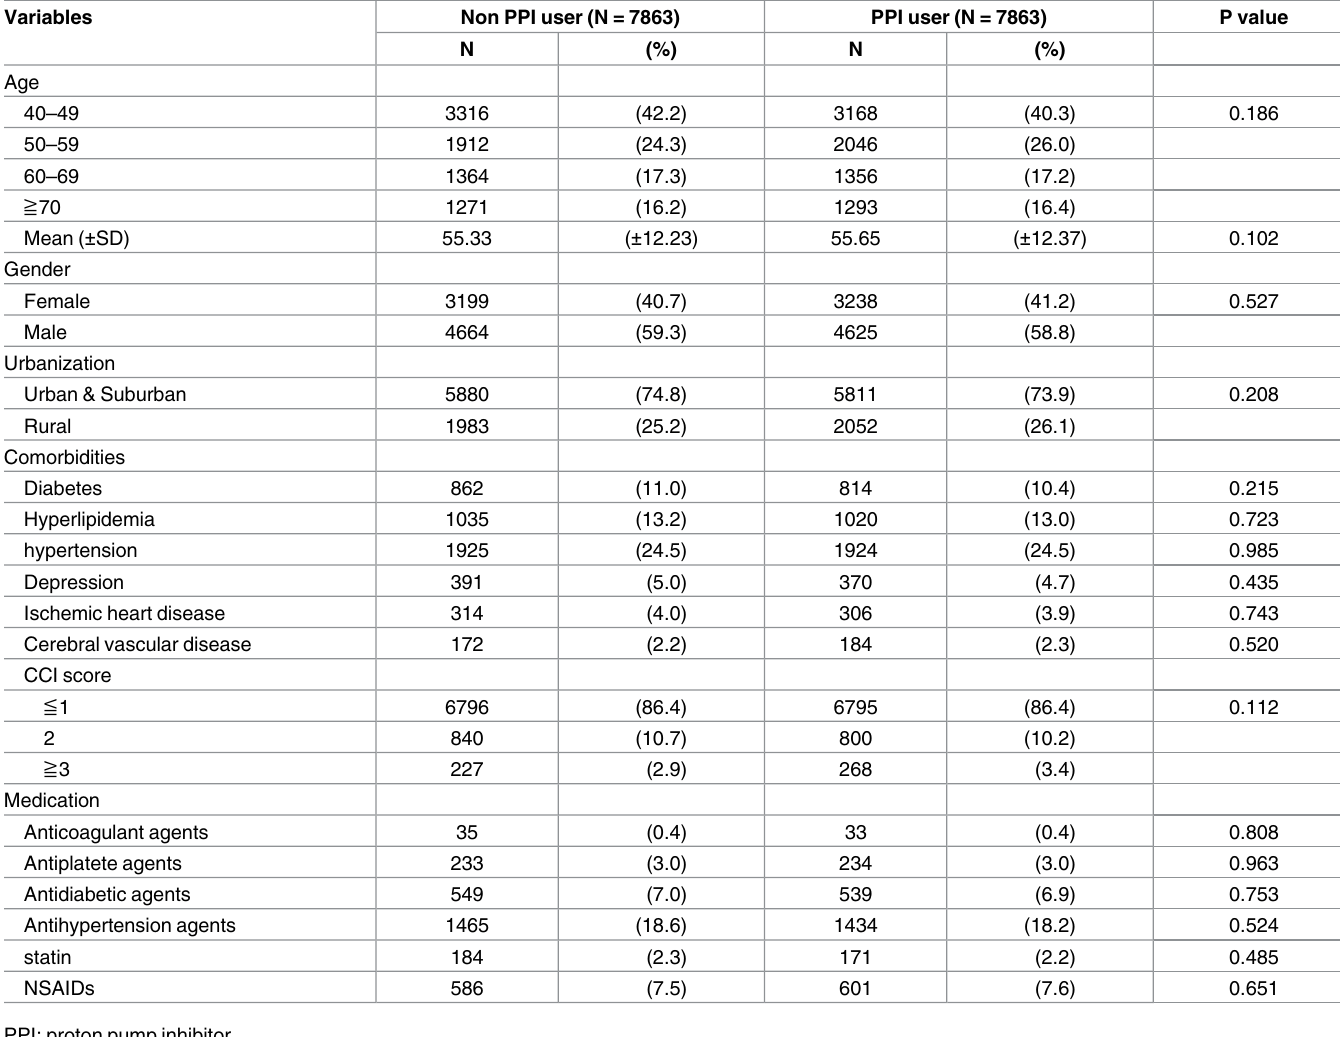
Table 1. Basic characteristics of PPI users and non—PPI users (N =